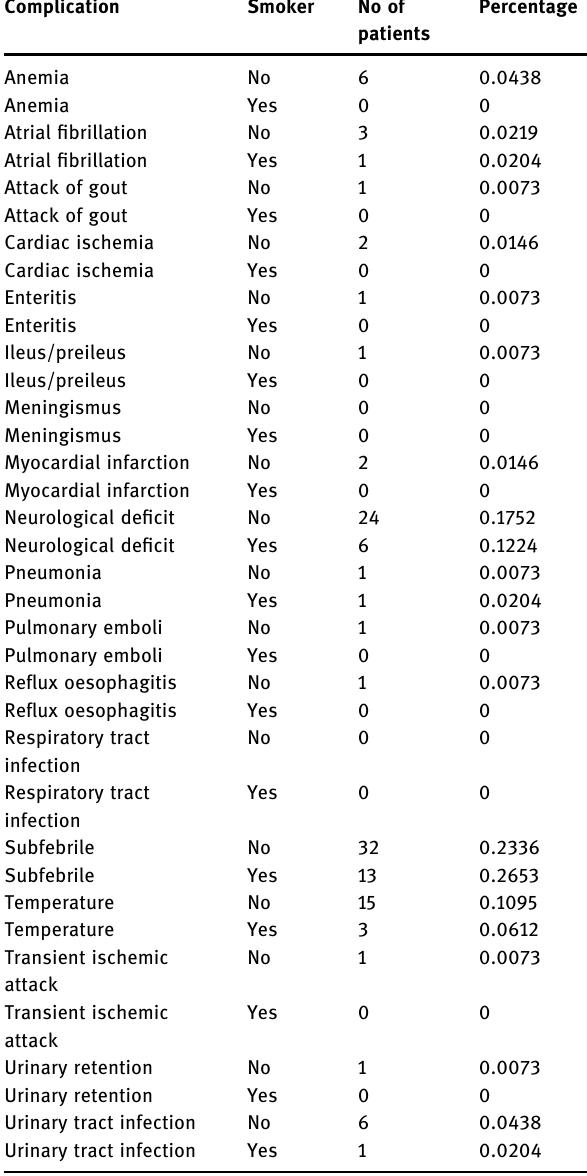
Table 1: Number and percentage of postoperative complications